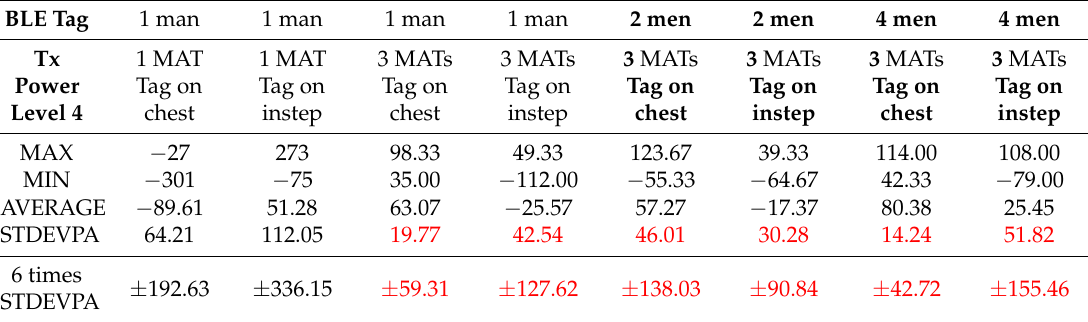
Table 18. Comparison of experiments with different numbers of runners, and different configurations of BLE Tags, in which runners ran through one or three sets of MAT.